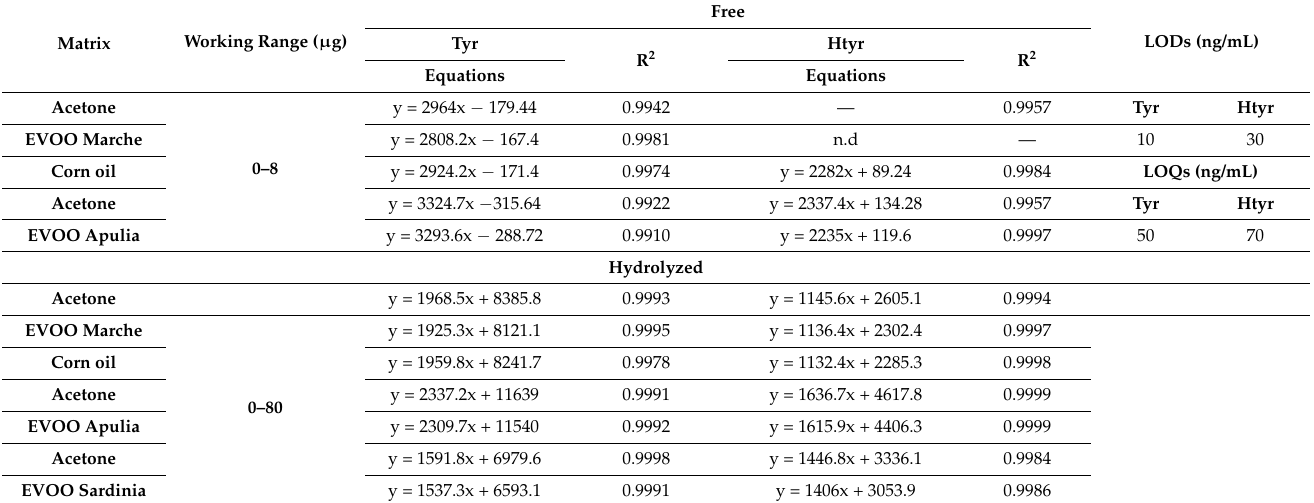
Table 2. Linear regression equations, LODs, and LOQs of free and hydrolyzed